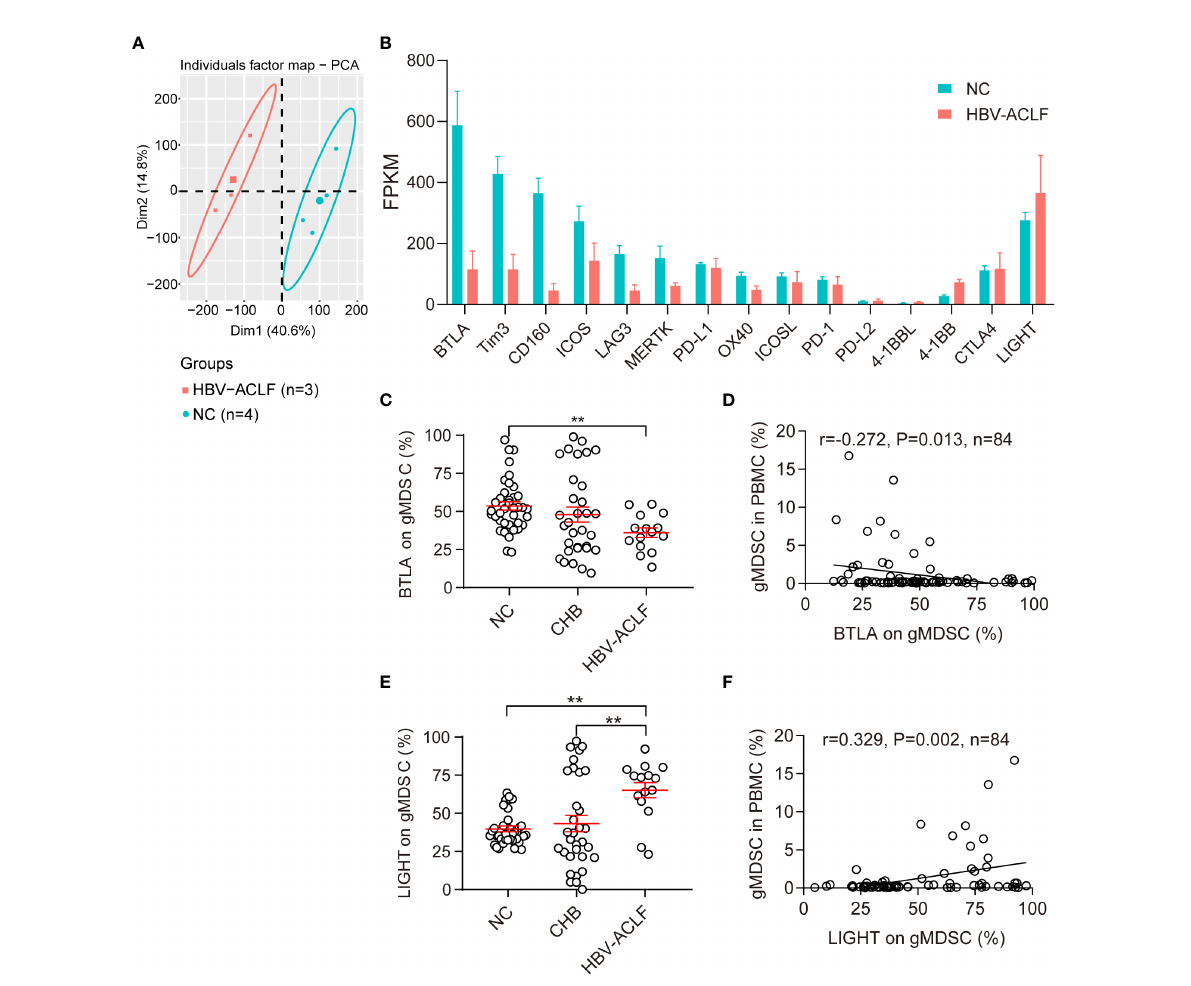
FIGURE 2 Phenotypic characteristics of gMDSC. (A, B) Differentially expressed genes in gMDSC from HC and HBV-ACLF patients. (C, E) Cumulative data for expression of BTLA (co-inhibitory molecule, C ) and LIGHT (co-stimulatory molecule, E ) in circulating gMDSC from patients with chronic HBV infection. (D, F) Correlation of circulating gMDSC proportion with BTLA (D) and LIGHT (F) expression in gMDSC. Error bars, mean ± SEM; one- way ANOVA followed by Fisher ’ s LSD multiple-comparison test (B, D) and Spearman tests (C, E) ; *P <.05, **P